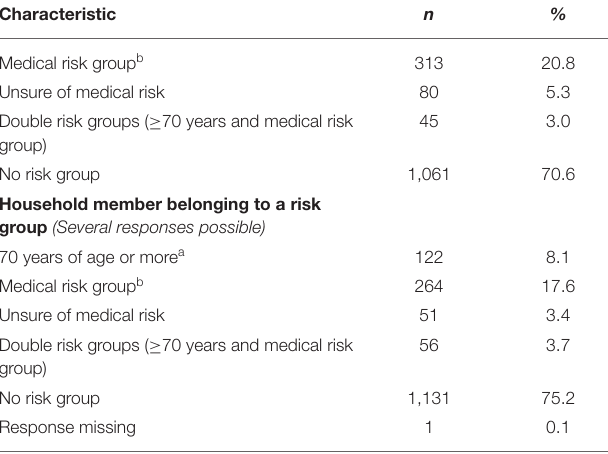
TABLE 2 | Characteristics of survey participants ( N = 1,503).